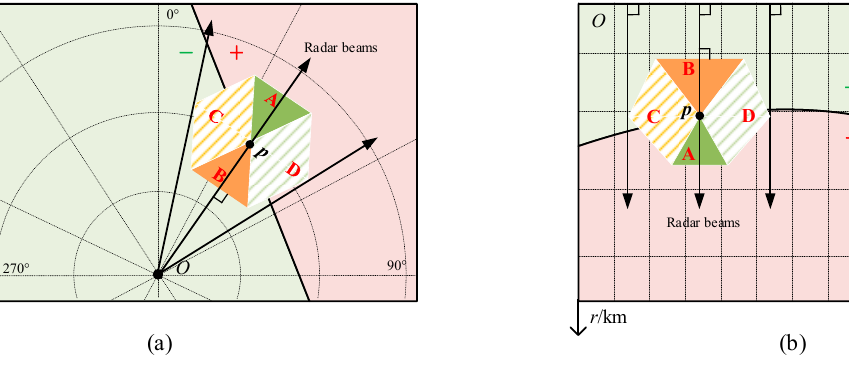
Figure 6. Template application diagram: ( a ) Application of the template in a θ - r polar coordinate system and ( b ) application of the template in a θ - r rectangular coordinate system. In ( a ) and ( b ), the green background areas represent the areas with negative radial velocity, while the pink background areas represent the areas with positive radial velocity. The arrows represent the radar beams.